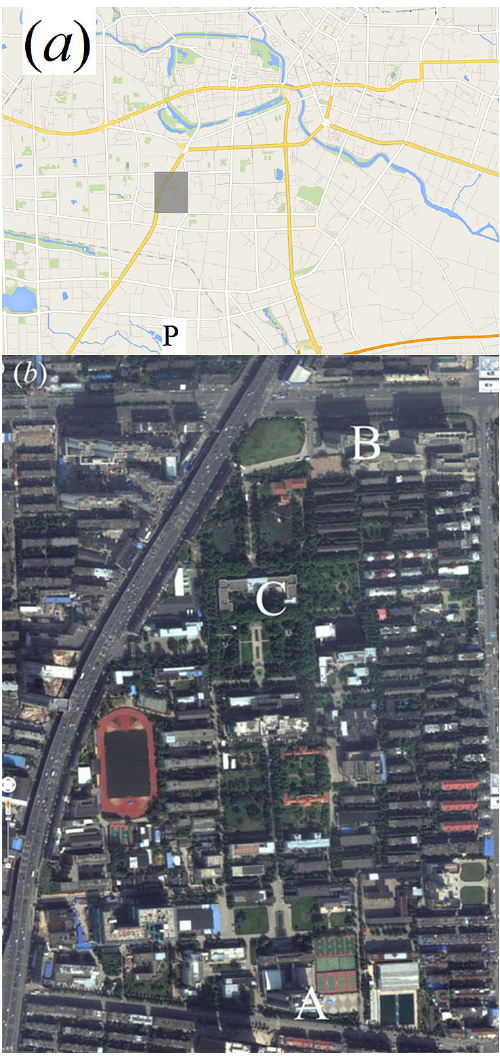
Figure 1. Photographs of the measurement site. (a) Map of Hefei City and (b) expanded view of the measurement site on the USTC campus, which is marked as the shaded rectangle in (a) . Point P in (a) indicates the site from which visibility and aerosol mass con- centration measurements were obtained. Points A and B in (b) show the locations of the transmitter and receiver, respectively. Point C in (b) marks the meteorological tower position. There are four heavy traffic roads surrounding the measurement site. Figure 1a and b